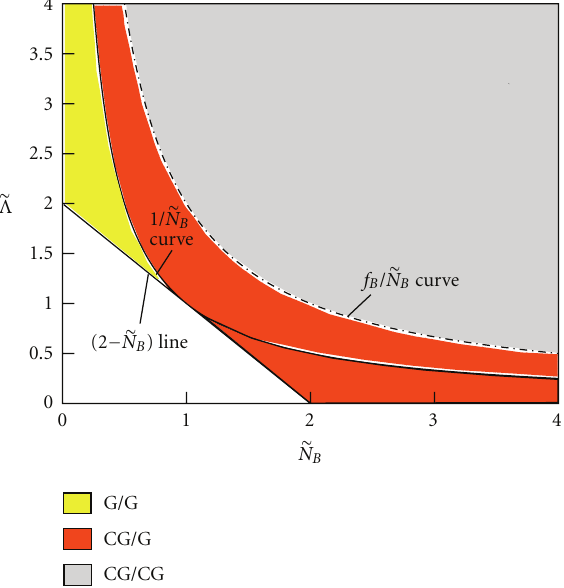
Figure 3: The domain of the three di ff erent possibilities for the turbulent flame brush structure in the plane ( (cid:2) Λ , (cid:2) N B ) for f B > 1.